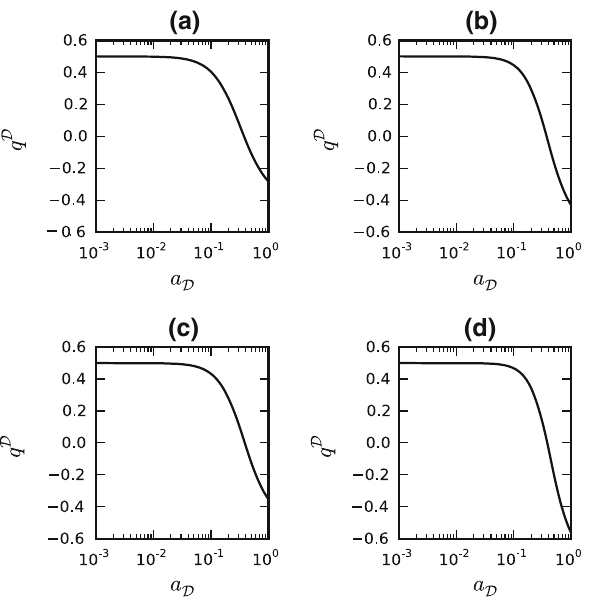
Fig. 9 Theevolutions of q D overeffectivescalefactor a D withbest-fit values of a n = − 1 . 22, Ω D 0 m = 0 . 12, b n = − 0 . 88, Ω D 0 m = 0 . 12, c n = − 1 . 04, Ω D 0 m = 0 . 13, and d n = − 0 . 58, Ω D 0 m = 0 . 12, respectively